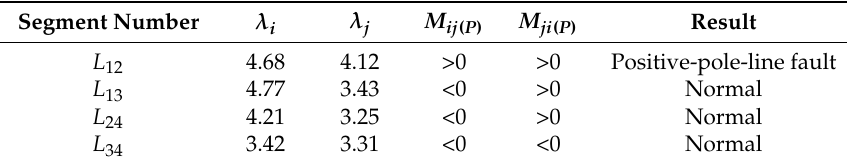
Table 2. Location results of monopolar fault.